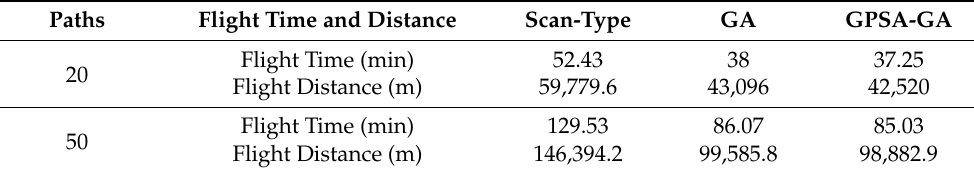
Table 4. Flight test results.